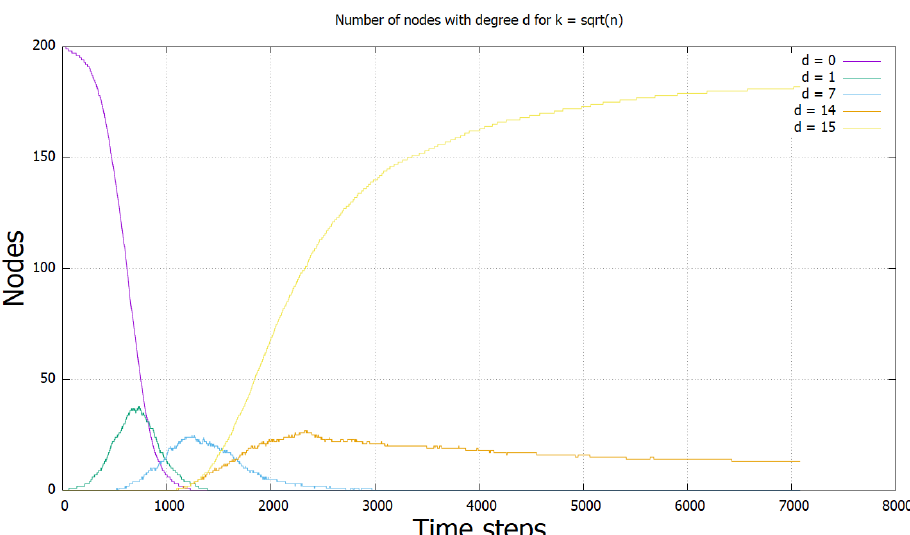
√ n . Both shifts are more